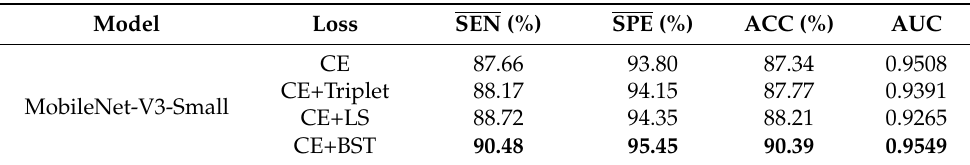
Table 10. The metrics for MobileNet-V3-Small on the osteosarcoma histology image dataset.